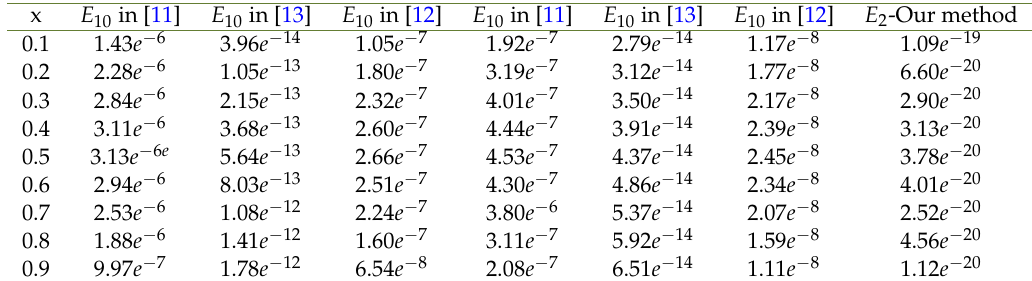
Table 1. Comparison of absolute errors of different methods for Example